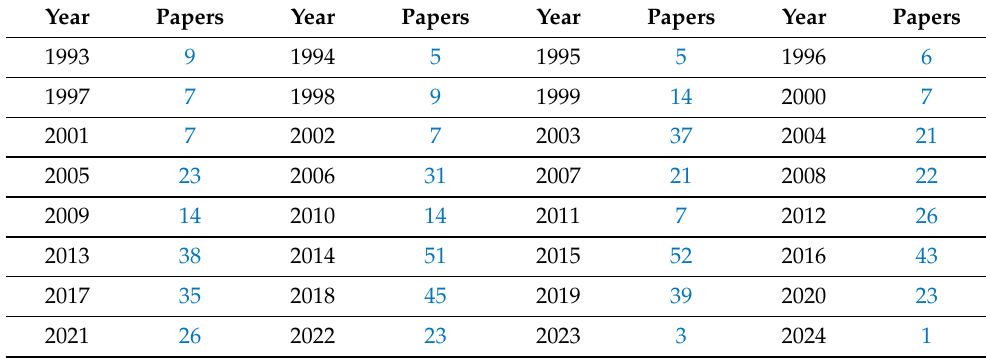
Table 1. The year distribution of Qi’s papers formally published since 1993.